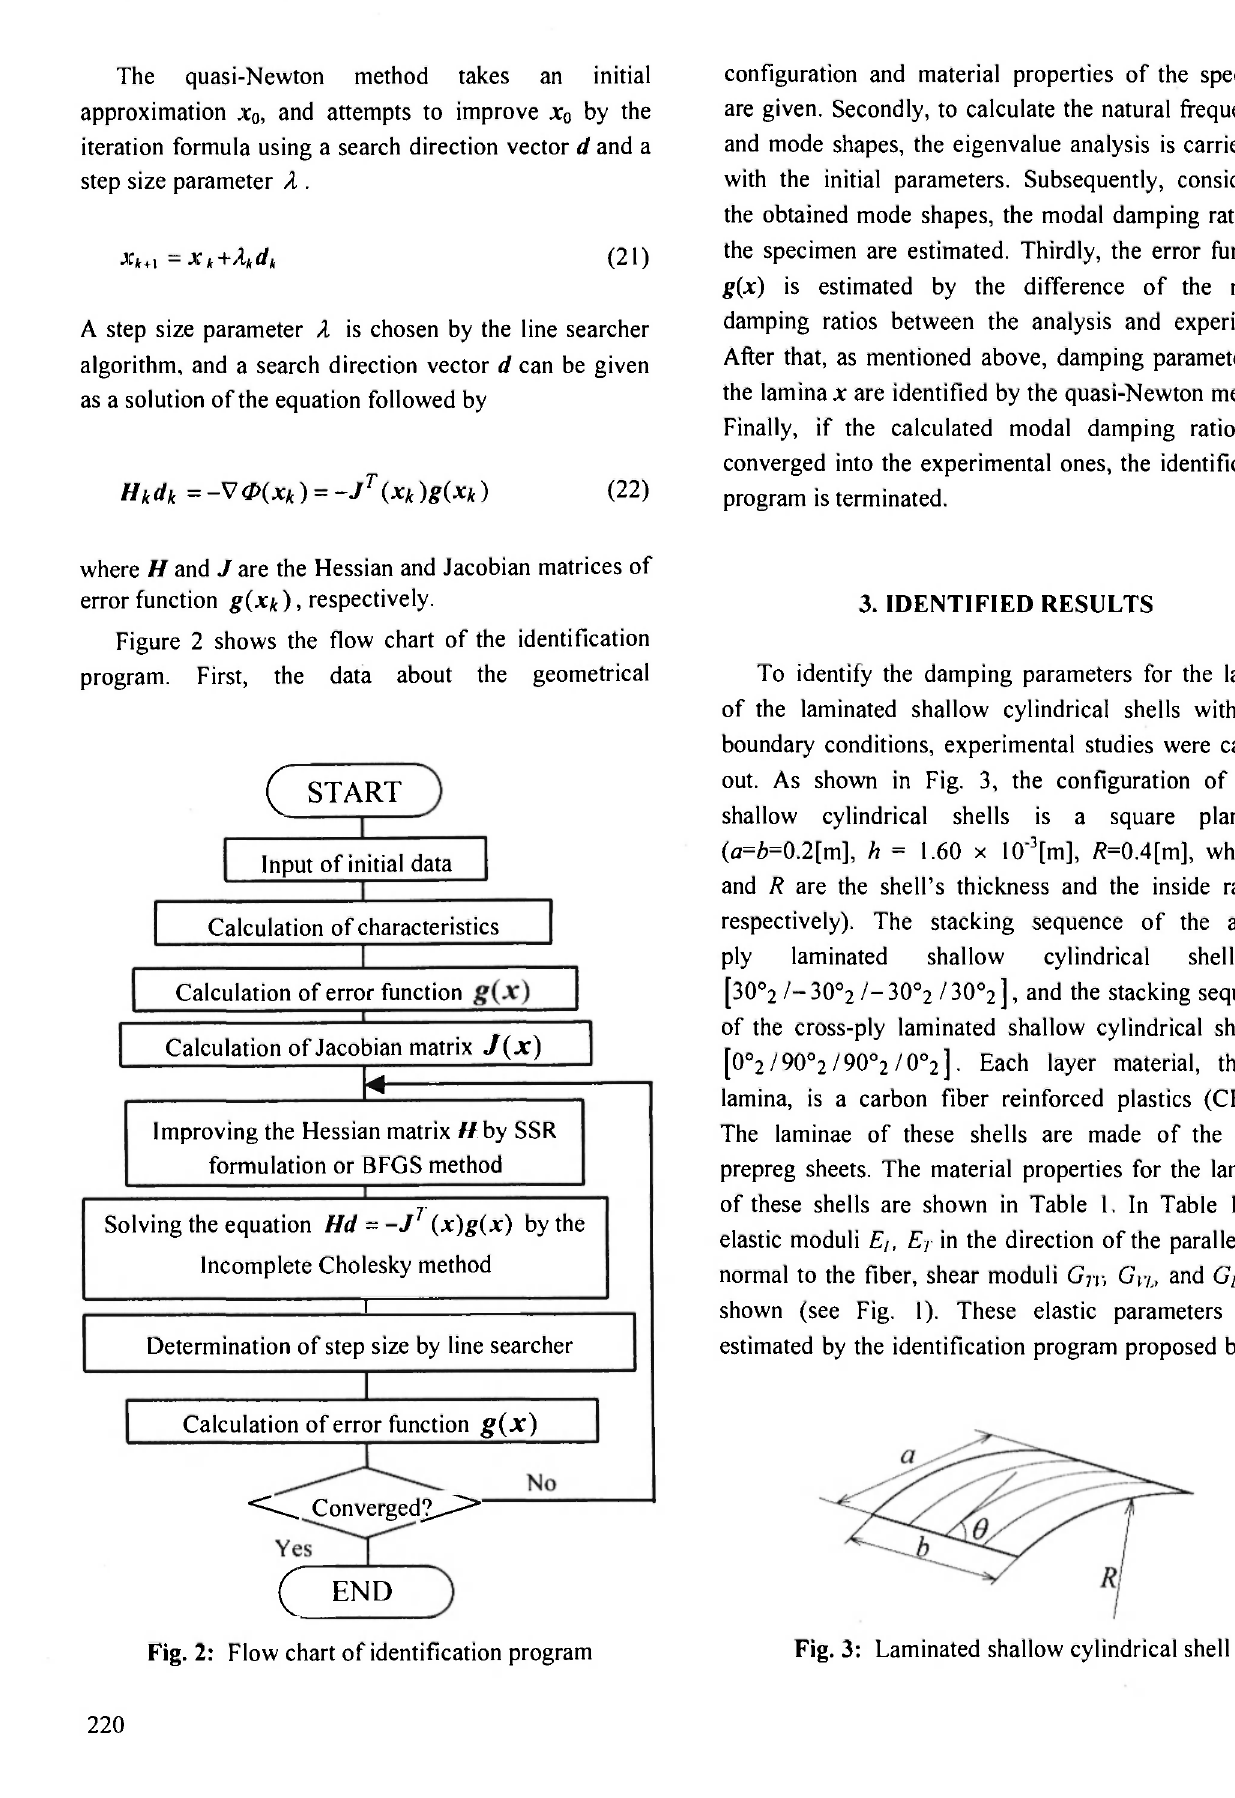
Fig. 3: Laminated shallow cylindrical